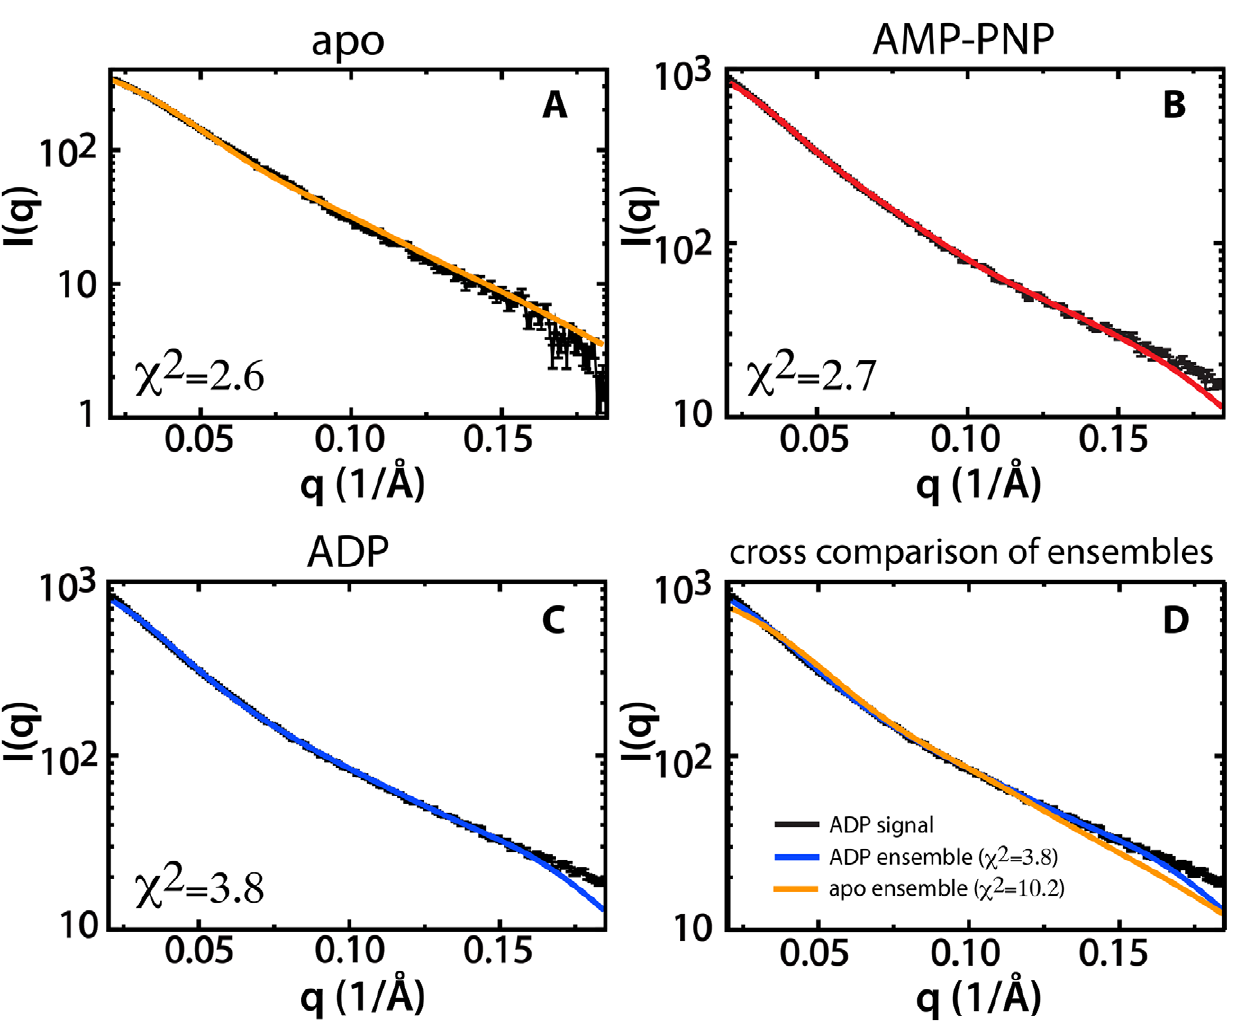
Figure 4. Theoretical scattering curves of the best-fitting conformational ensembles fitted to the experimental scattering curves (black) for apo Csk (A, orange), AMP-PNP bound Csk (B, red), and ADP-bound Csk (C, blue). The x 2 value for the ensemble fit to the experimental data appears in the lower left corner of the plot for each curve. A comparison of the fit of the apo Csk ensemble (orange) and the ADP- bound ensemble (blue) to the ADP experimental data (black) appears in D. doi:10.1371/journal.pcbi.1002695.g004 and shifts in population during kinase catalysis. The energy